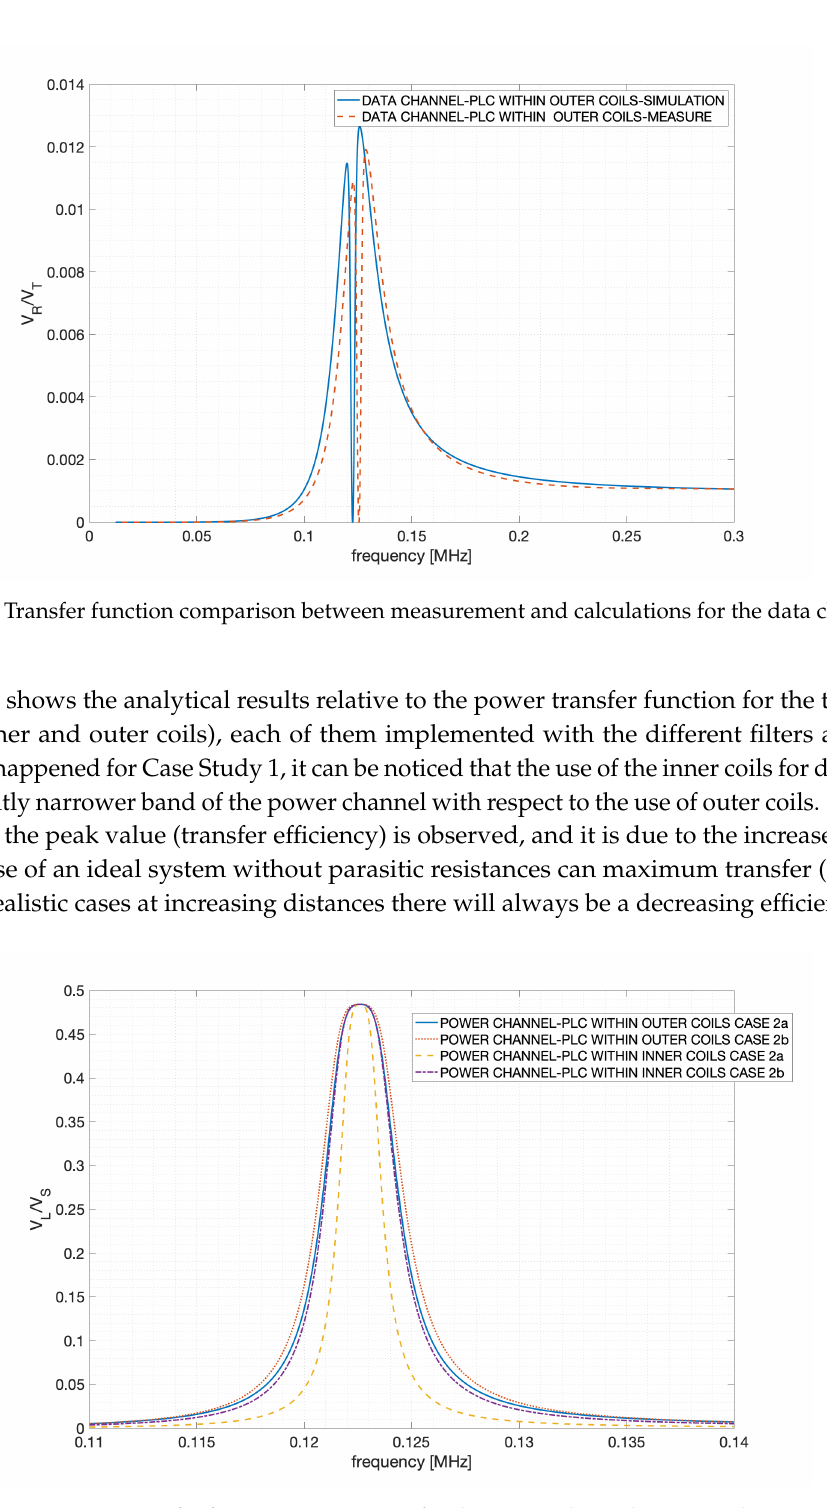
Figure 15. Transfer function comparison for the power channel, Case Study 2. Table 6. Filter parameters for Case Study